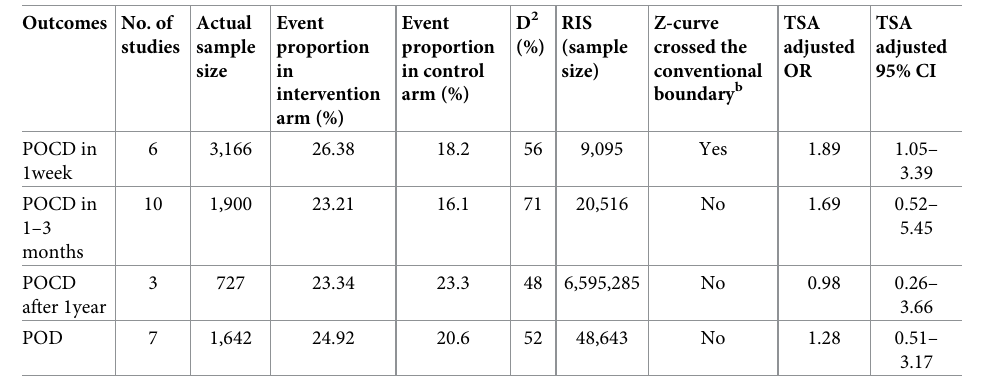
Table 4. Trial sequential analysis of the incidence of POCD or POD a